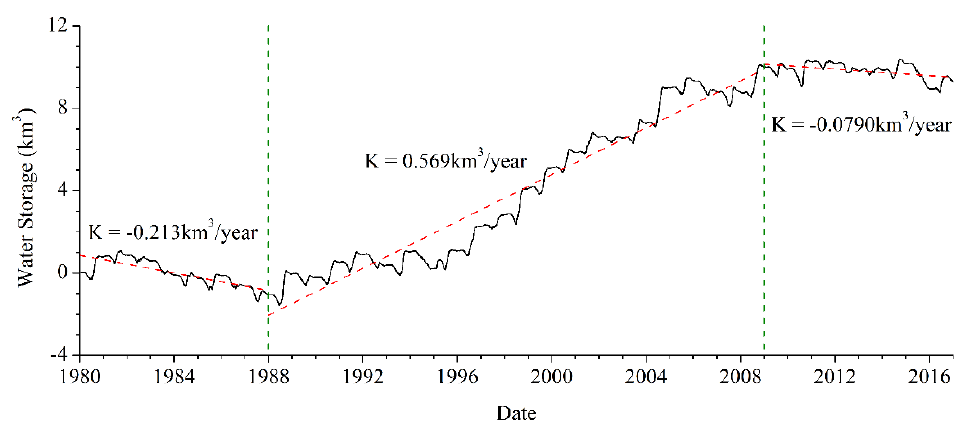
Figure 10. The simulated daily LWS of Nam Co Lake from 1980 to 2016. The red dotted line (linear fitting) and green dotted lines (period dividing) are given for reference.